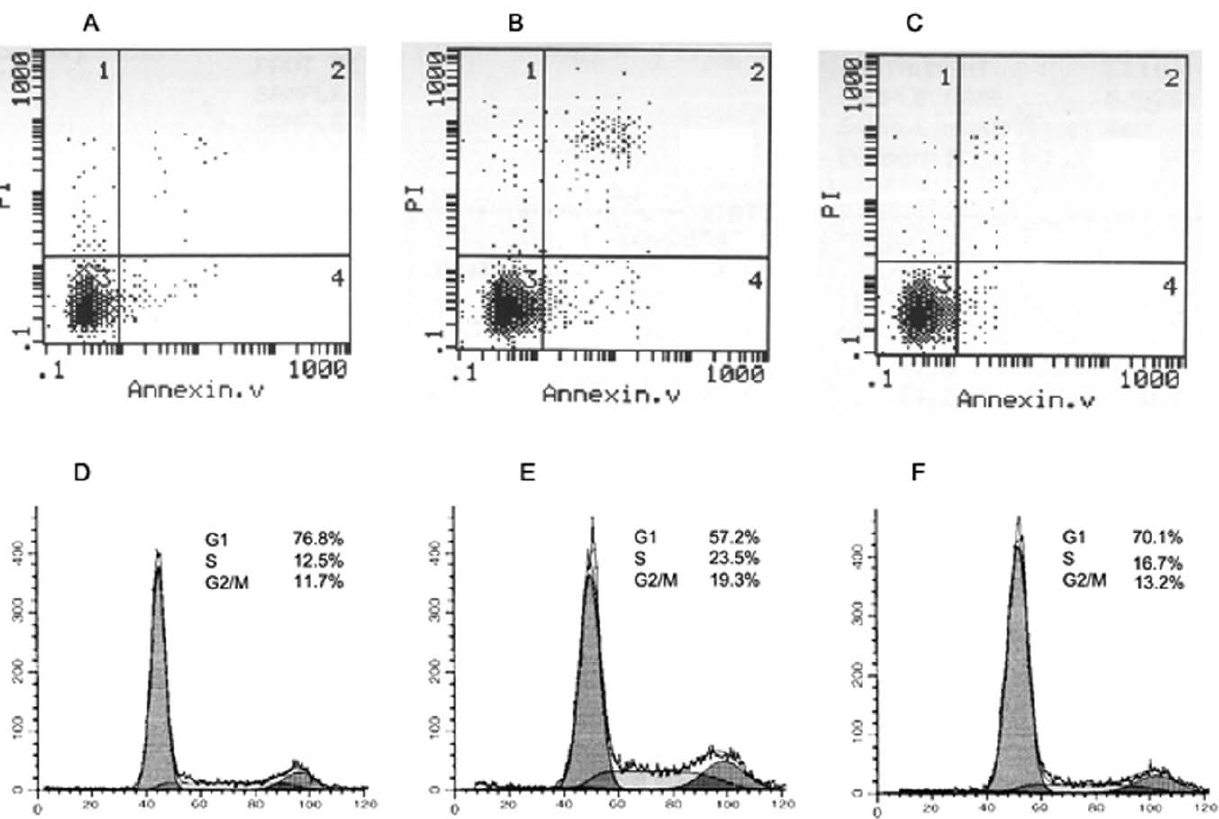
Figure 6. Cell cycle effects in DRG neurons after exposure to mechanical pressure. After cells were subjected to 0.1 MPa or 0.5 MPa of pressure, an increase in the number of apoptotic cells was observed 24 h after injury. Treatment with PD150606 significantly decreased the number of apoptotic cells in cells exposed to either 0.1 MPa or 0.5 MPa of pressure (P , 0.05, n=5). (A) control cells, (B) cells treated with 0.5 MPa of pressure, and (C) cells treated with 0.5 MPa of pressure and PD150606. Cell cycle distribution was examined 24 h after exposure to mechanical pressure in the different groups: (D) control, (E) cells treated with 0.5 MPa of pressure, (F) cells treated with 0.5 MPa of pressure and PD150606.